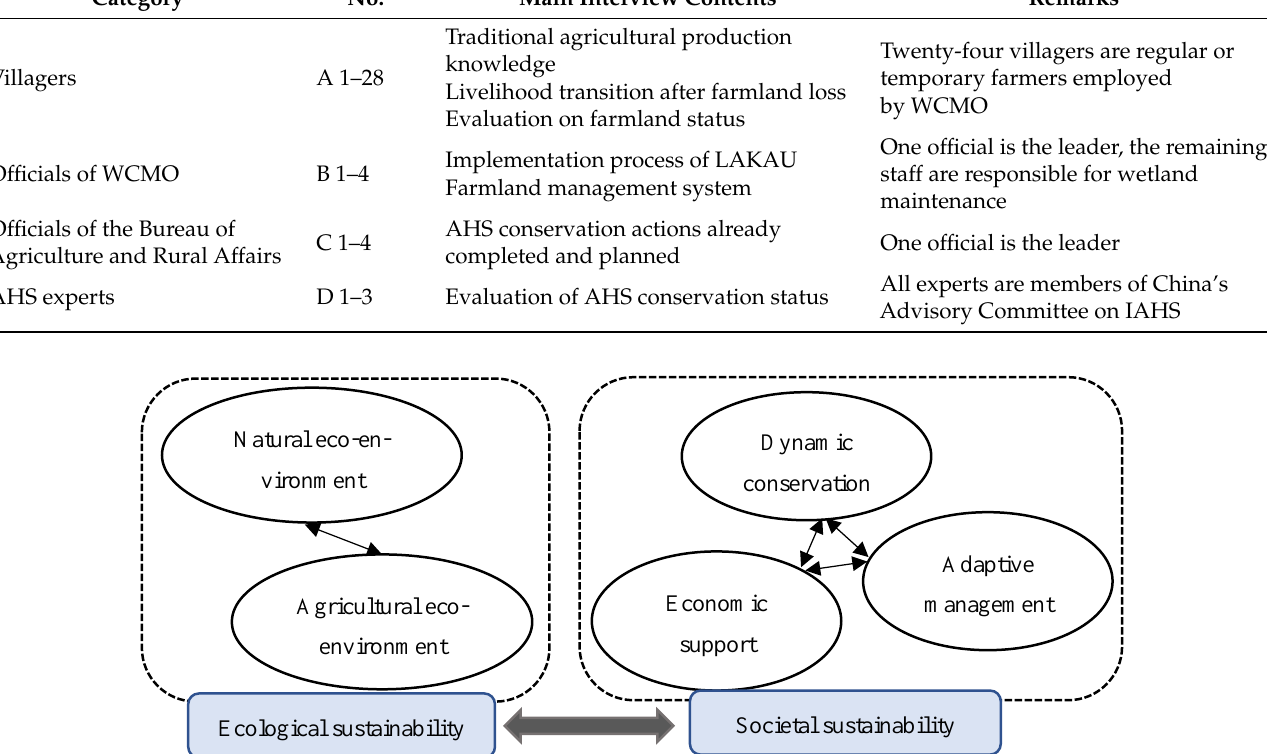
Table 1. Basic information of interview samples.